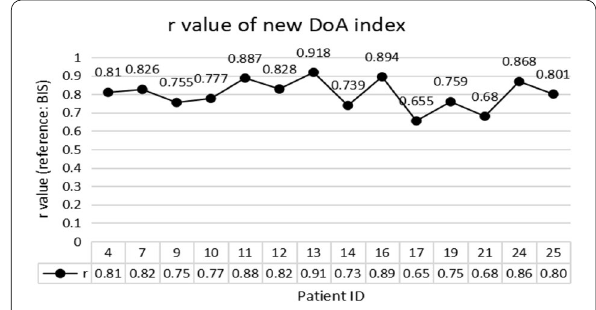
Fig. 9 The performances of the new DoA index for randomly selected 14 patients ( r values)